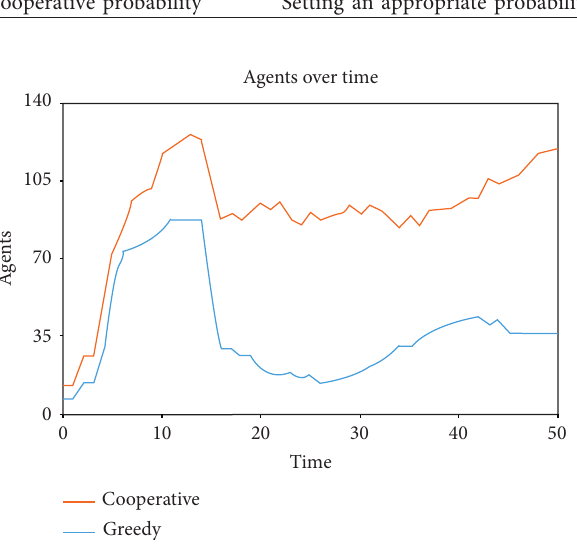
Figure 6: Early simulation interface.